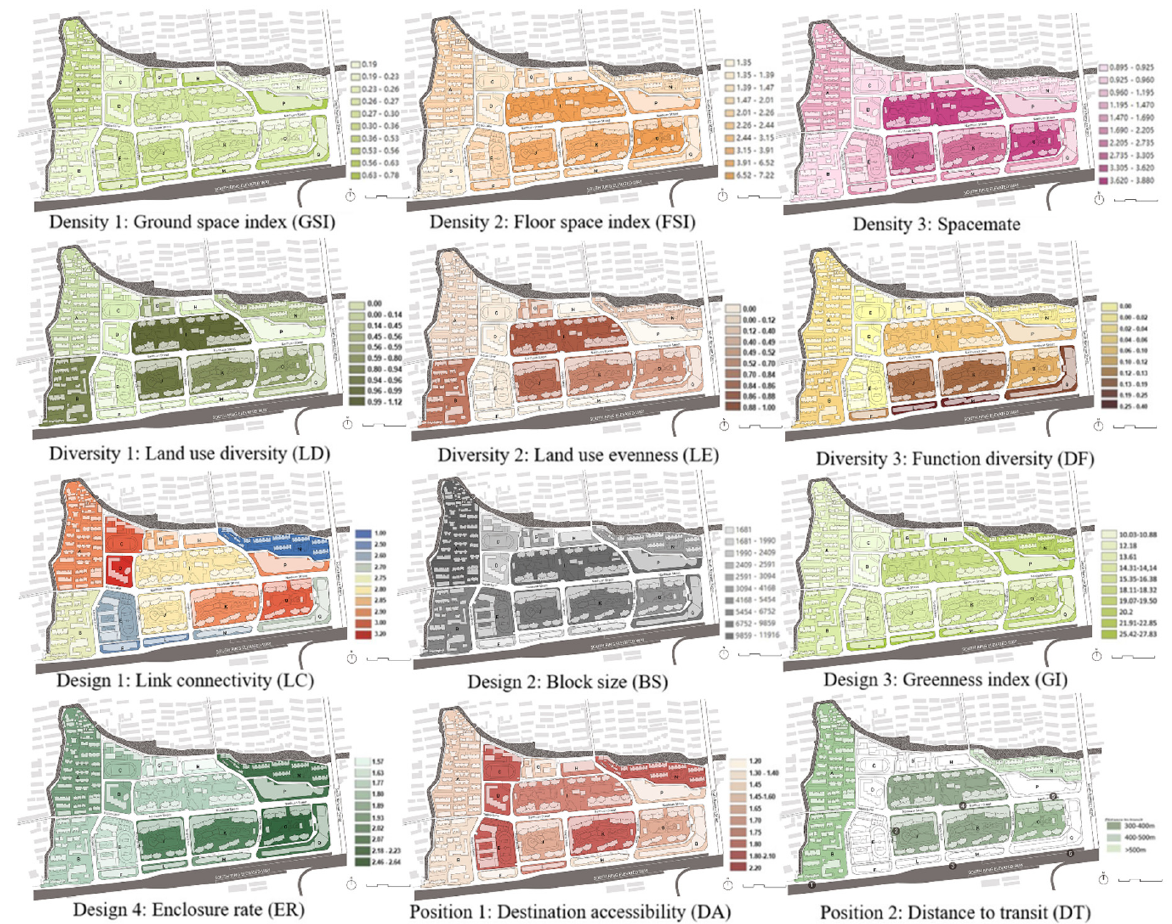
Figure 5. Visual estimation results of the 12 indicators affecting vitality in the 5D model. We employed the AHP to compare the ‘5d’ influencing factors in terms of their weight on community vitality and compute the composite impacts of ‘5d’ variables on the potential distribution of community vitality. The first column (A-Q) represents the 17 blocks in Nanhuan New Village based on the street cut-out. The second to 13th columns (GSI-DT) represents the quantified results of the 12 indicators in the 5D model for each block, calculated from Table 2. The last column (PVI) indicates the potential vitality of each block based on the 12 indicators quantified using the AHP method. As described in Table 3, the weights of density, diversity, design, and position are 0.4236, 0.2270, 0.2270, and 0.1223, respectively, so the final vitality was obtained by multiplying each quantitative indicator D i × X i ). The data in by its corresponding weight and adding them together (PVI = ∑ 9 i = 1 Figure 5 are derived from Table 6 and visualised on the map using